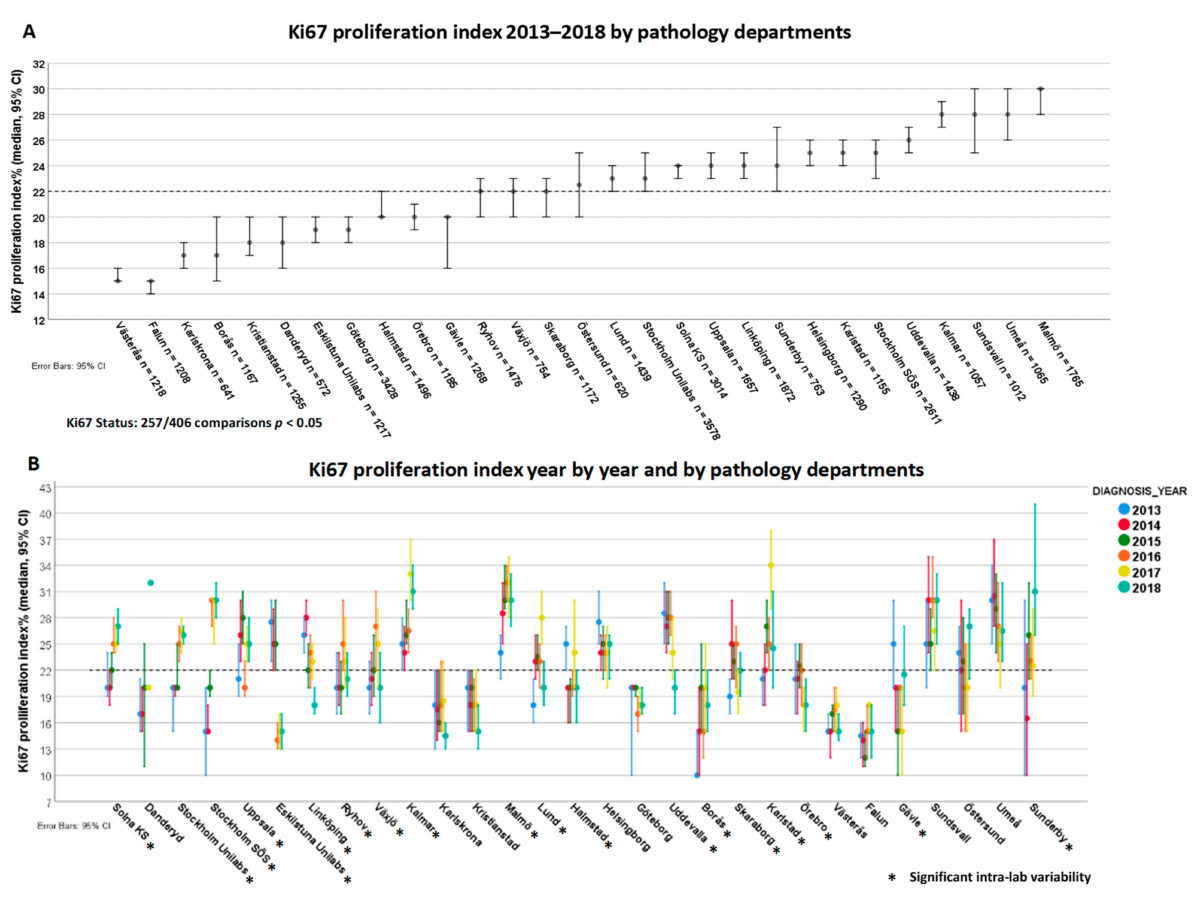
Figure 4. Inter- ( A ) and intra-laboratory variability ( B ) for Ki67 among 29 pathology